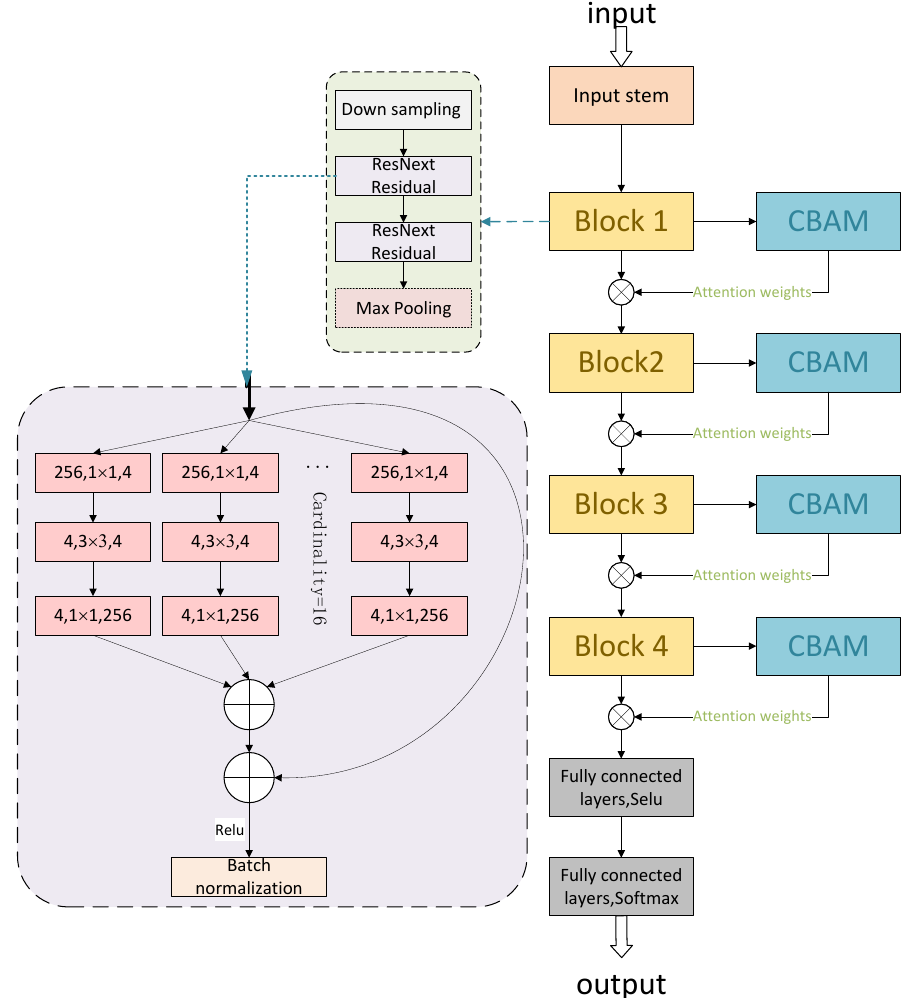
Figure 6. ResNext network model based on attention